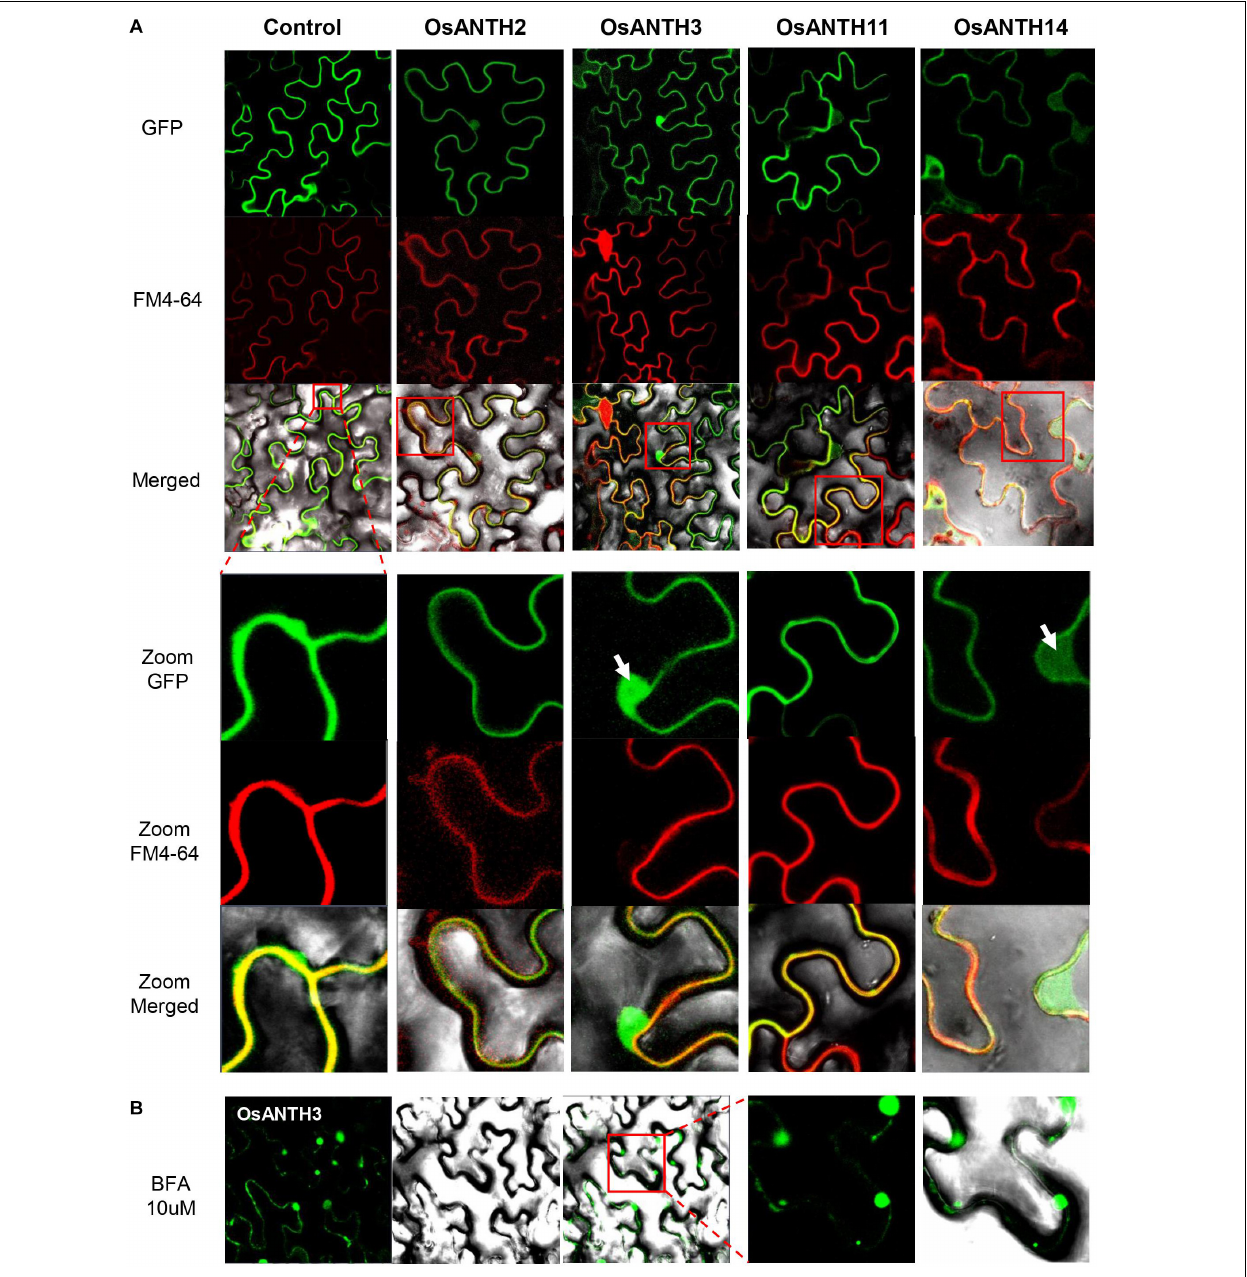
FIGURE 4 | Subcellular localization of Oryza satvia AP180 N-terminal homology domain-containing (OsANTH) proteins in tobacco leaves using laser scanning confocal fluorescence microscopy. (A) Upper panel shows green fluorescence in tobacco epidermal cells in leaves infiltrated with four OsANTH-green fluorescence protein (GFP) fusion proteins, the center panel shows the same leaves stained with FM4–64, and the lower panel shows the merged images from GFP, FM4-64, and bright field. The focused image is the plasma membrane (PM) and shows an enlarged portion of the red box displayed in the merged pictures. Yellow signals show a merged image from the OsANTH localization and PM signal. The white arrows indicate the signal not merged with the PM (OsANTH3-nucleus, OsANTH14-cytoplasm). (B) The first panel shows green fluorescence in tobacco epidermal cells of leaves infiltrated with OsANTH3-GFP fusion proteins when treated with 10 µ M BFA. The second panel shows the images in bright field. The third panel shows the merged images from GFP and bright field. The last two panels are GFP and merged images that enlarge the red box in the third